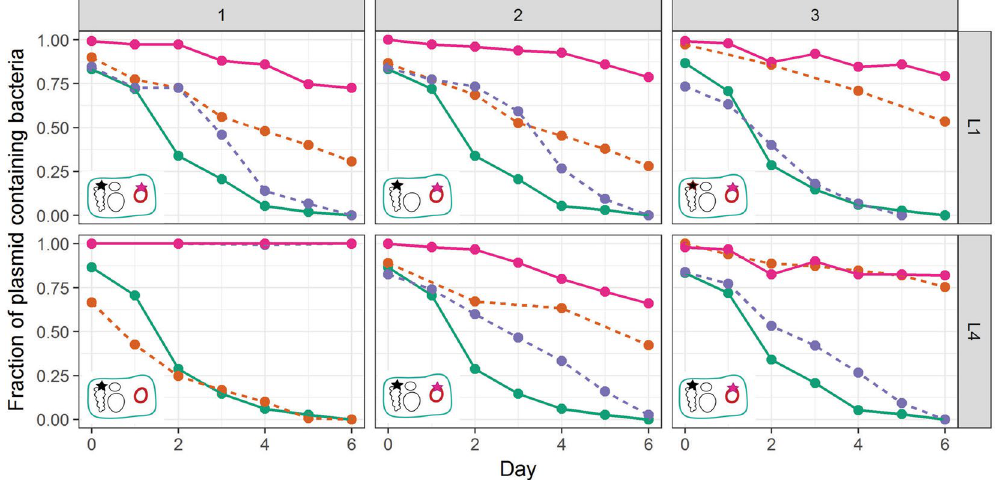
Figure 1. Persistence of the ancestral and evolved plasmids in the ancestral and co-evolved hosts from lineages L1 and L4 (clones L1-1, L1-2, L1-3 and L4-1, L4-2, L4-3, indicated as 1,2 and 3 above the panels). Solid lines: ancestral and evolved clones; dashed line: permuations of evolved/ancestral host/plasmids;